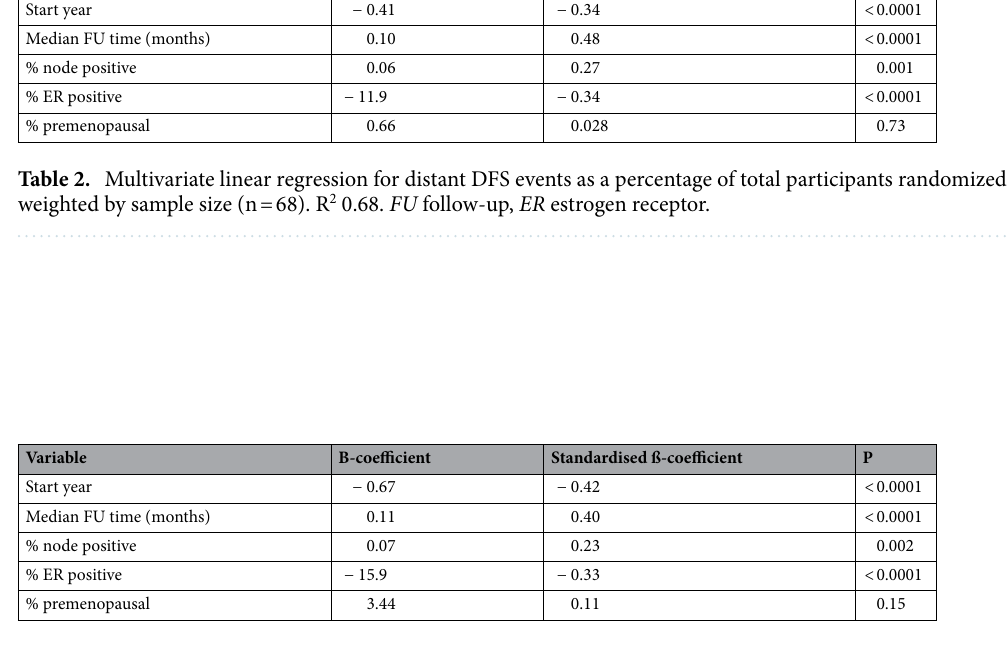
Table 3. Multivariate linear regression for BC related DFS events as a percentage of total participants randomized, weighted by sample size (n = 68). R 2 = 0.71. FU follow-up, ER estrogen